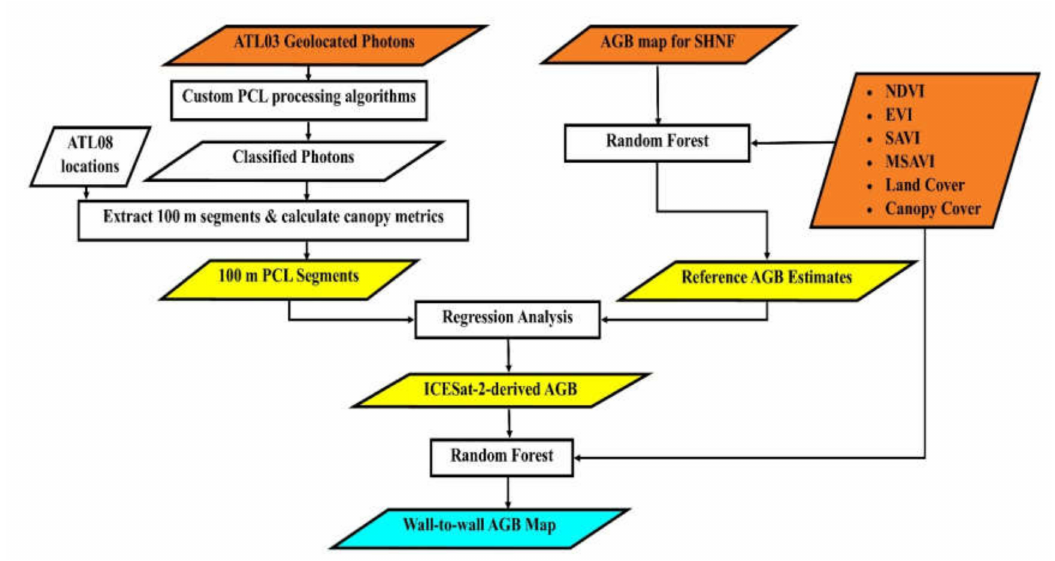
Figure 1. An overview of methods used in this